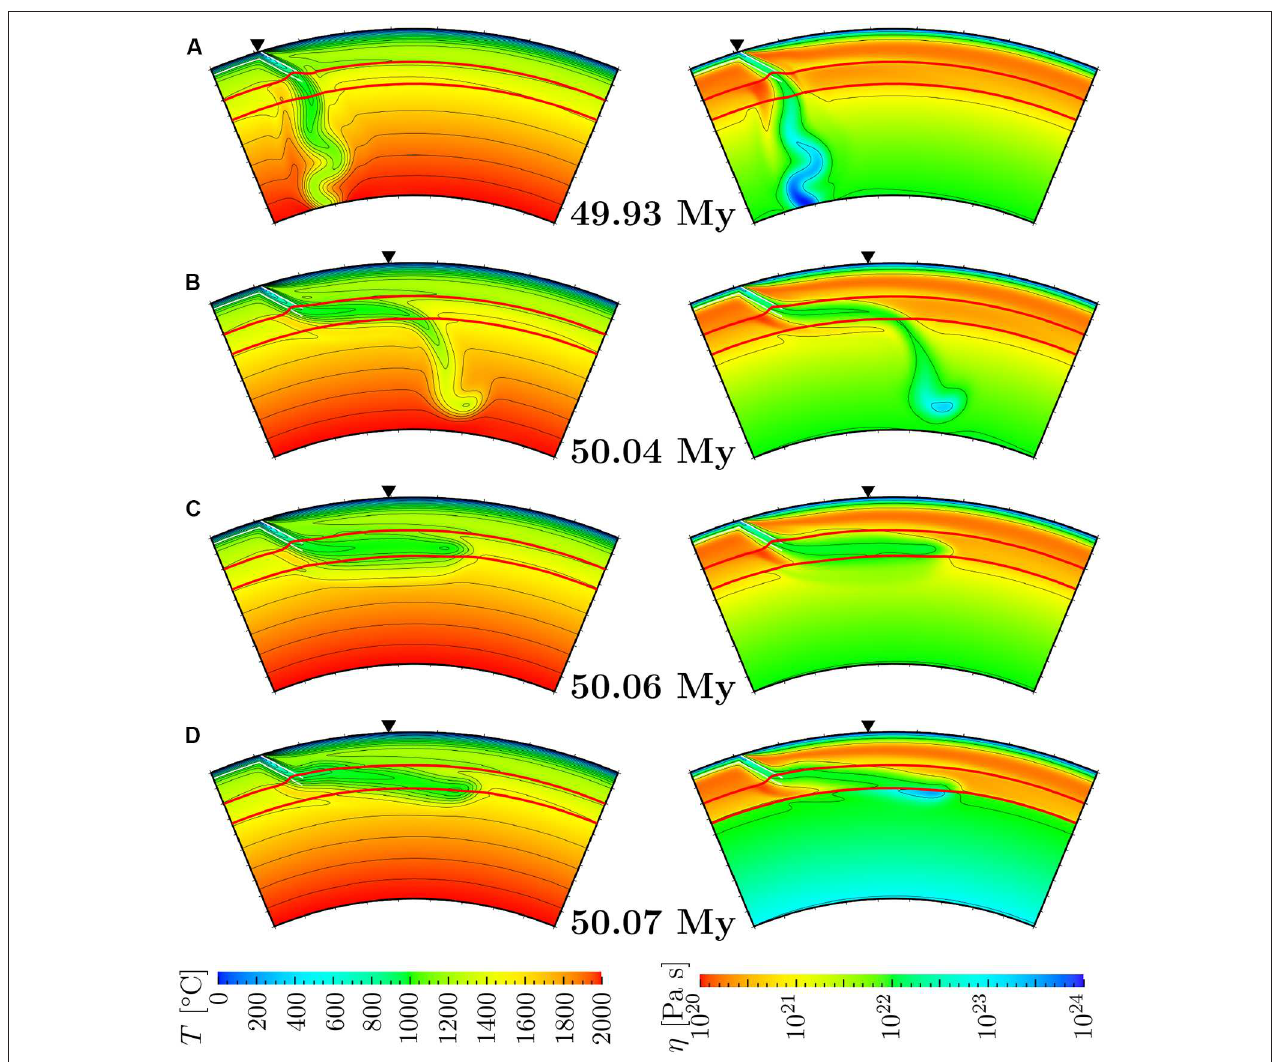
FIGURE 2 | Snapshots of the distribution of temperature T (left) and viscosity η (right) at around 50 My after the initiation of subduction for (A) reference case ( v tr cm/yr, r η 1, γ 660 -1 MPa/K), (B) case with lager trench retreat velocity ( v tr = = ( v tr 3.15 cm/yr, r η 1, γ 660 -3 MPa/K), and (D) case with larger viscosity jump ( v tr = = = shown in colors with the contour lines at 1,000, 1,100, 1,200, 1,300, 1,400, 1,500, 1,600, 1,700, 1,800, and 1,900 [ ◦ C], and the values of viscosity η are shown in colors with contour lines at 10 20 , 10 21 , 10 22 , 10 23 , and 10 24 [Pa s]. The color scales are shown at the bottom of figure. The red lines indicate the phase boundaries around 410 km and 660 km, while the thin white lines indicate the channel of the cold descending fluid. In each figure, the initial positions of trench are indicated by the black